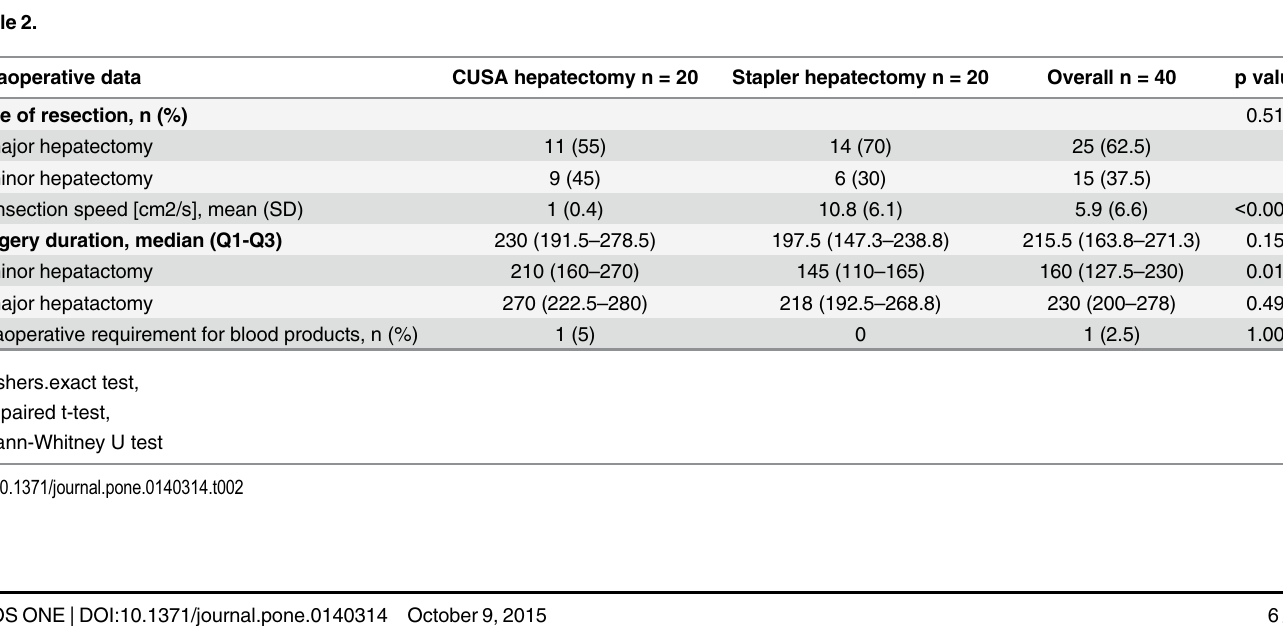
Analyzing both groups separately revealed that systemic IL-6 was similar in patients under- going CUSA and stapler resection, respectively (Fig 3a). The specific IL-6 increase during parenchymal transection was significantly higher in patients with CUSA LR in the portal vein (40.6 (11.9) pg/ml vs. 14.4 (2.4) pg/ml; p = 0.026), hepatic vein (29 (8.2) pg/ml vs. 13.2 (2.4) pg/ ml; p = 0.042) but not systemically (25.6 (8) pg/ml vs. 14.5 (2.3) pg/ml; p = 0.352) (Fig 3b). Investigating the impact of surgery duration on inflammatory response revealed a significant correlation between IL-6 levels measured at the end of surgery after skin closure and the overall length of surgery (CUSA: p = 0.029, r = 0.489; Stapler: p < 0.0001, r = 0.797; Overall: p <